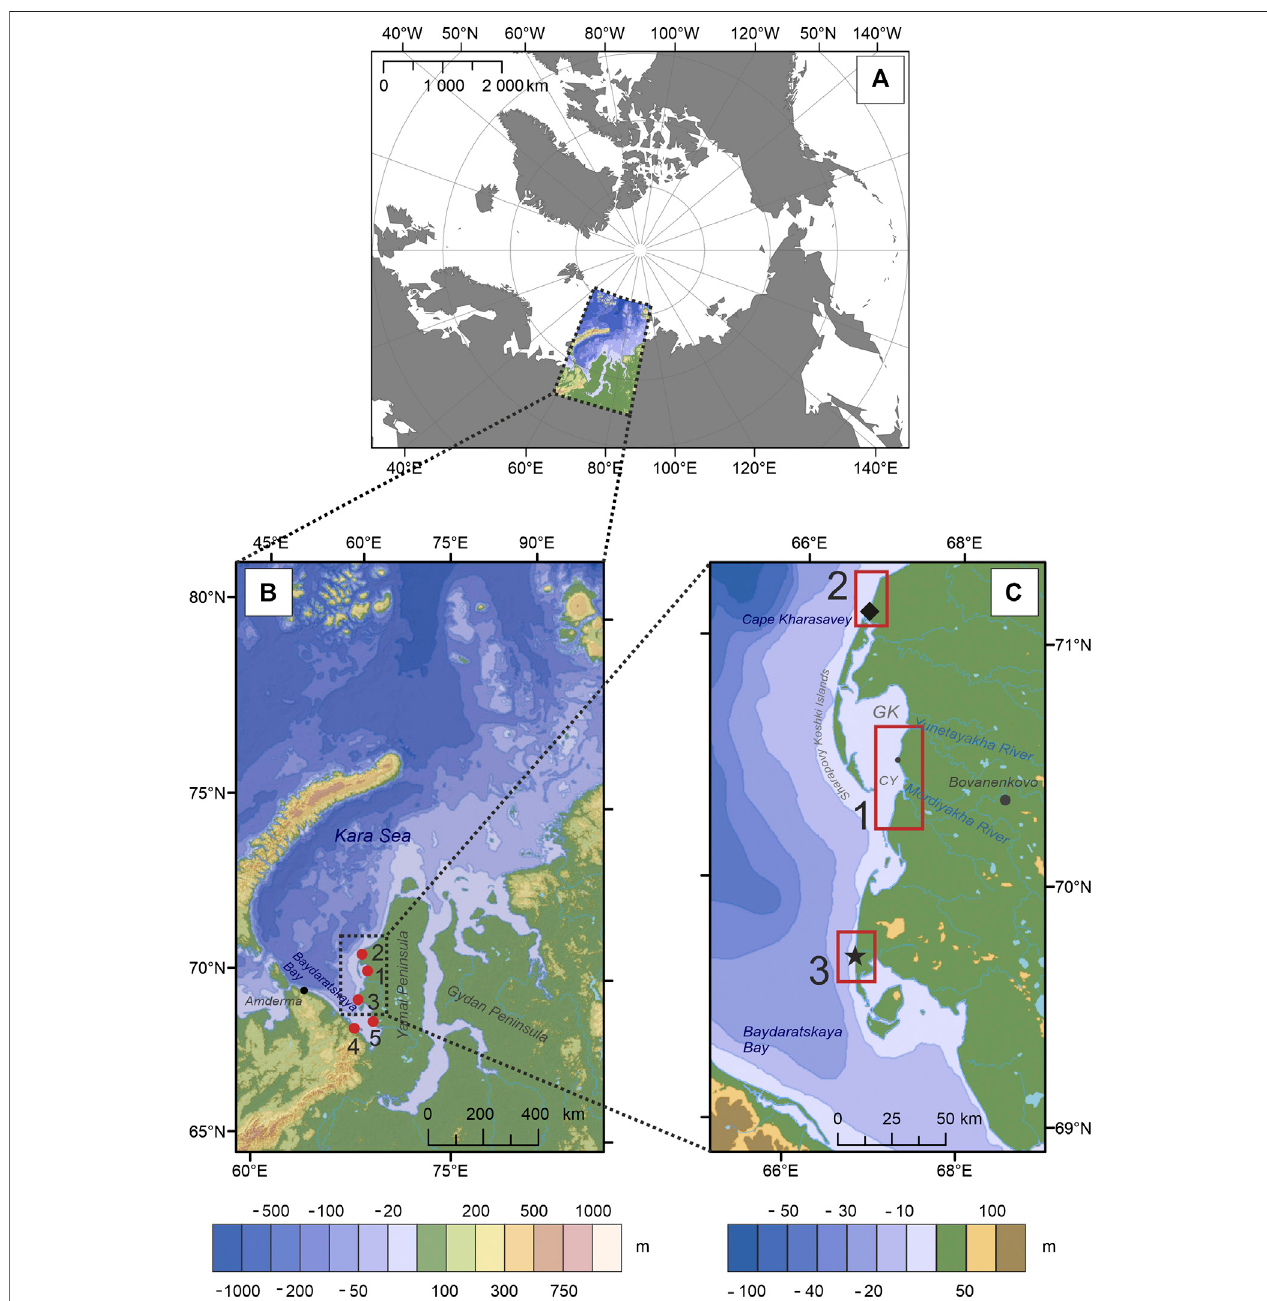
FIGURE 1 | Position of the study area and other key sites of coastal dynamics ’ monitoring mentioned in the text. 1 — Gulf of Kruzenstern, Eastern Coast; 2 — Kharasavey, 3 — Marre-Sale, 4 — Ural coast of the Baydaratskaya Bay, 5 — Yamal coast of the Baydaratskaya Bay. Marresalya hydrometeorological station at Marre- Sale is shown with an asterisk; Kharasavey hydrometeorological station is shown with a diamond. Abbreviations: GK — Gulf of Kruzenstern, CY — Cape Yasalya.